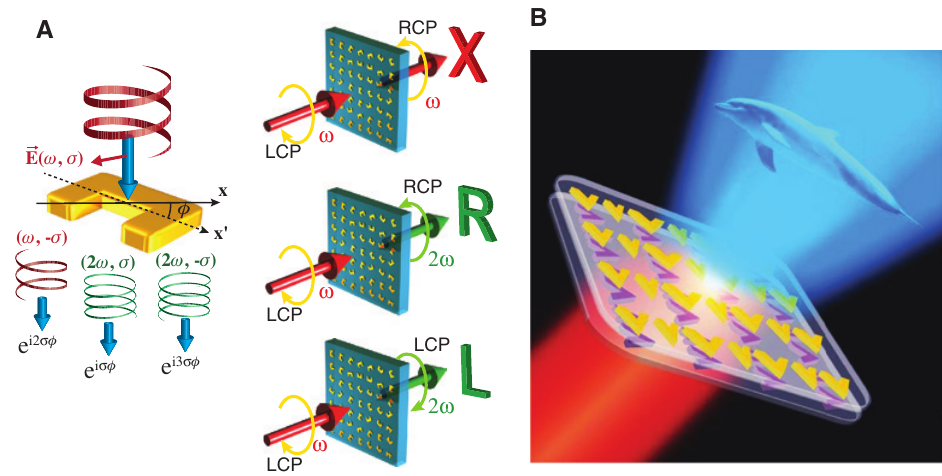
Figure 8: Nonlinear metasurface holography. (A) Schematic of the nonlinear phase modulation principle using the split-ring resonators with C1 symmetry, together with the spin- and wavelength-dependent holographic images at different channels [38]. (B) Nonlinear metasurface hologram composed of double-layer V-shaped antennas for the third-harmonic generations of holographic images [39]. Reprint permission obtained from [38,